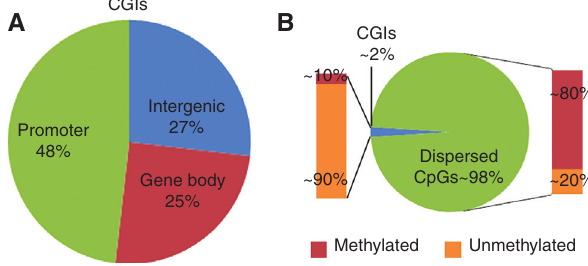
Figure 1 Genomic distribution of CpG islands (CGIs) and methyla- tion status of CpGs.